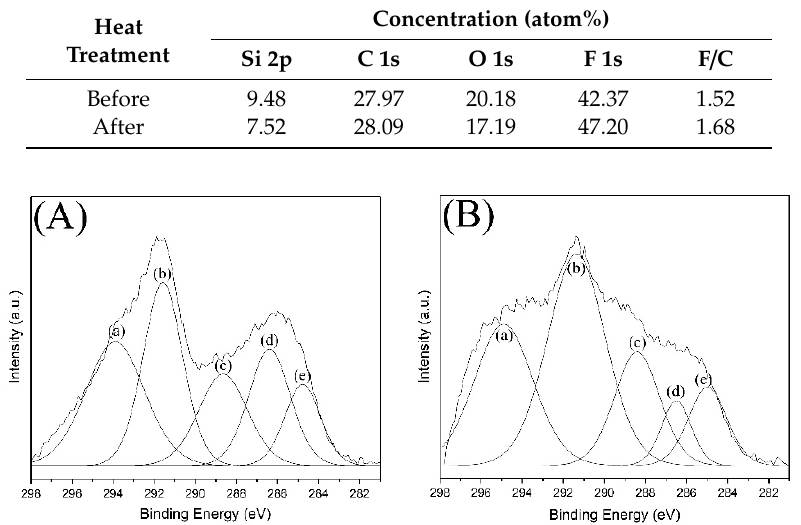
Figure 9. XPS profiles of the spray-coated 12 nm-SiO 2 (46)@PFMA surface before and after heat treatment at 150 °C. Table 2. Element concentration of the spray-coated 12 nm-SiO 2 (46)@PFMA surface by XPS analysis.